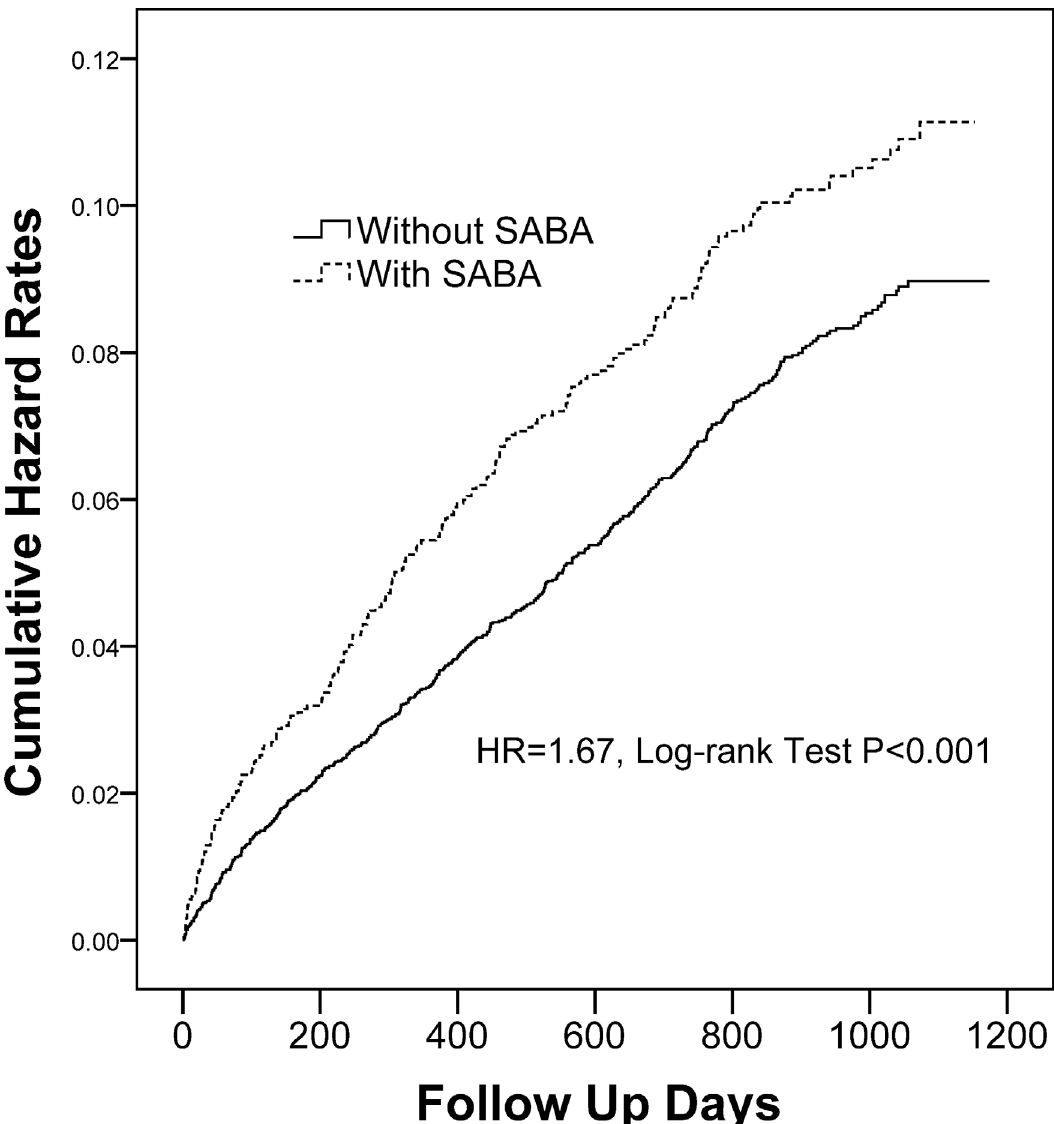
Fig 1. Cumulative incidence of stroke in COPD patients treated with and without inhaled SABA. COPD = chronic obstructive pulmonary disease; SABA = short-acting β -agonist.